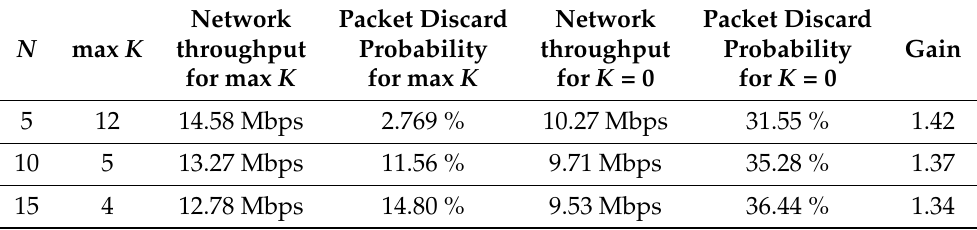
Table 2. Network throughput as a function of offered load for N = 5 and K = 0,1,5, and 30.